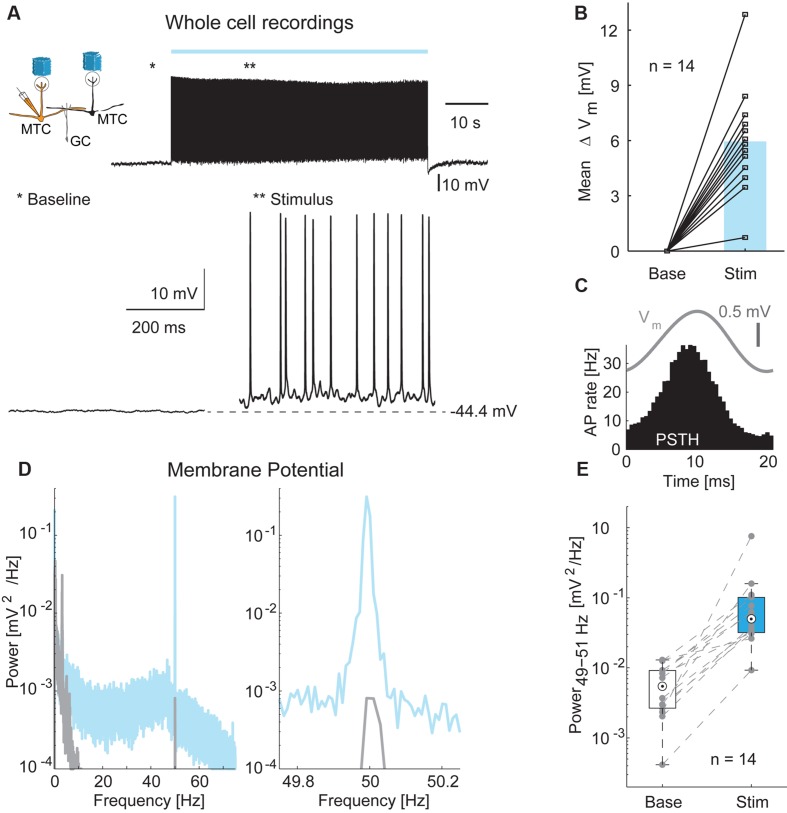
Membrane potential changes during optical stimulation. (A)
Top left: Simplified diagram of the probed MTC/GC circuitry. Right: Example trace from a whole-cell recording of a MTC during 1 min stimulation. Bottom: Zoom-in on baseline period and stimulation period indicated by asterisks. (B) Membrane potential depolarization during stimulation compared to baseline without optical stimulation. Blue bar, median, n = 14 whole-cell recordings. (C) Average membrane potential (Vm, gray) and PSTH (black) of a single cell triggered on all frame transitions (0.5 ms time bins, 30,000 frames). (D) Membrane potential power spectral density of a single cell before (gray) and during (blue) optical stimulation. Right, zoom-in on γ-frequency around 50 Hz. (E) Membrane potential modulation (49–51 Hz) before and during optical stimulation for all 14 MTCs recorded intracellularly.